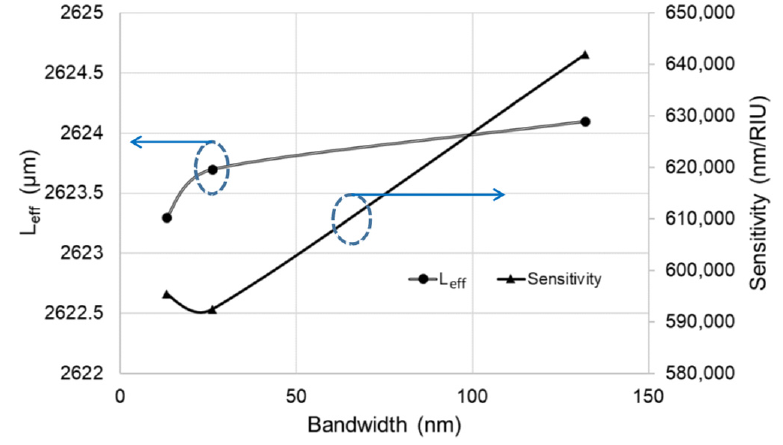
Figure 8. The comparison for the sensitivity and effective length among various bandwidths of input lights.